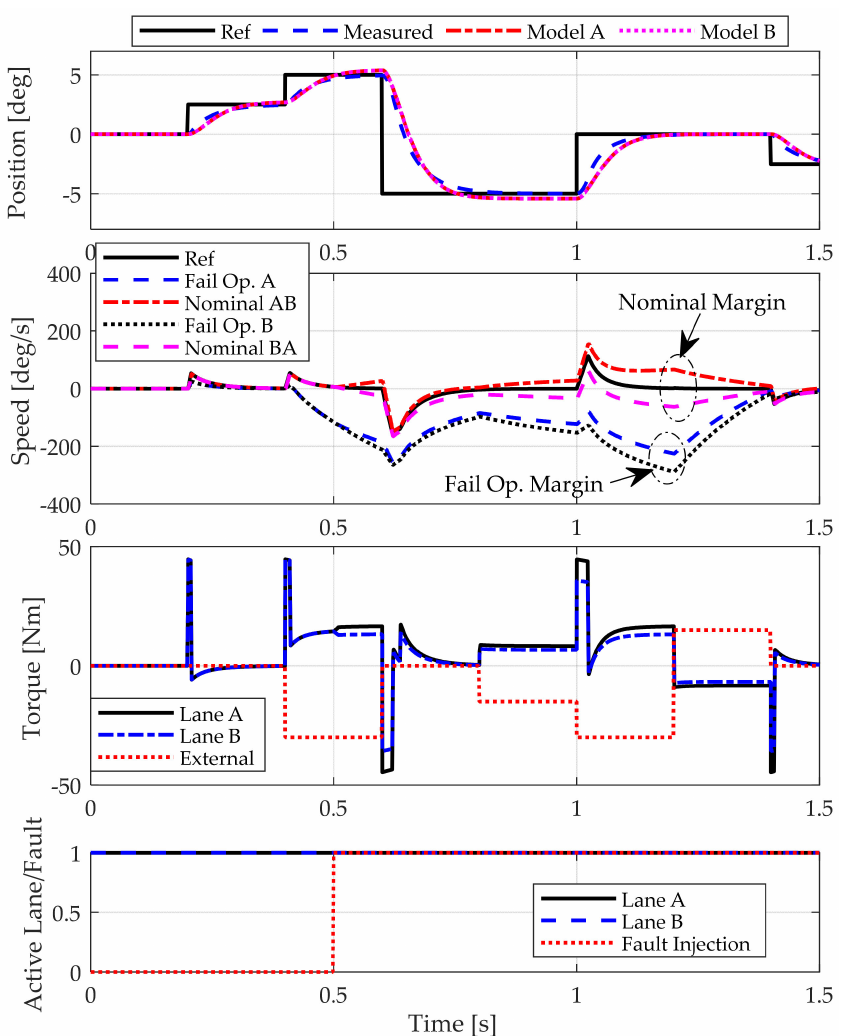
Figure 20. Example of a nominal operation after an operational marginal fault, fault ID = 2 in Table 3. The second case study is for fault ID = 18, where the controller of Lane A is discon- nected after 0.5 s, as shown in Figure 21. The fault has been detected by a diversion from the reference speed to the speed of the fail-operational A (ILM A ). This diversion initiated a mode transition after 0.061 s of injecting the fault. There is no significant deviation for the position tracking error after the fault injection because the actuator reconfiguration maintained that desired position-tracking